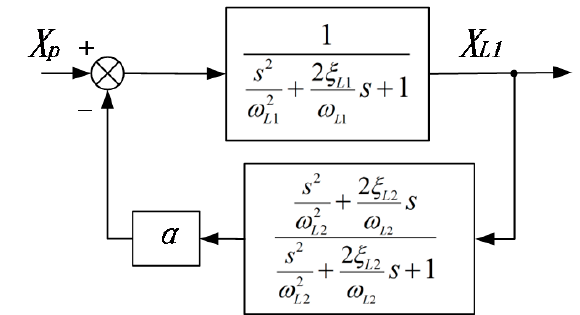
Figure 5. The control block diagram of the thrust vector dynamics.